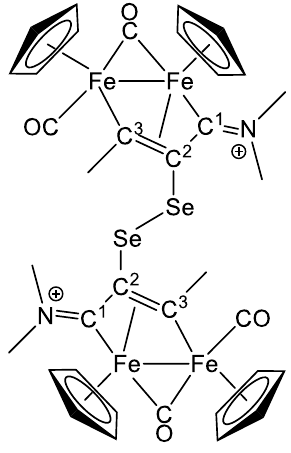
Chart 4. Structure of the cation of 4a .